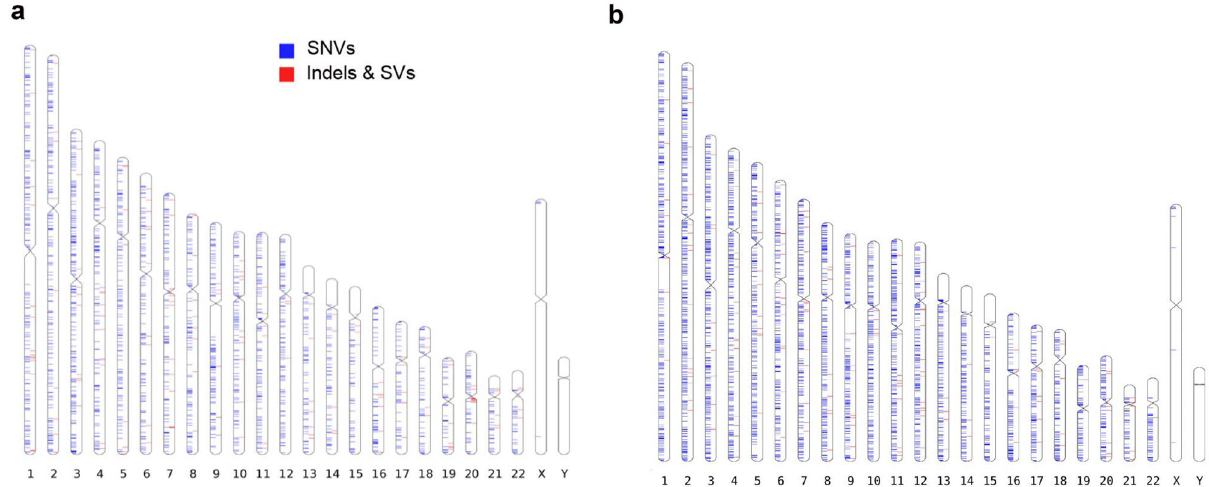
Figure 3. Chromosomal distribution of de novo mutations found in this study. ( A ) control families ( B ) NTV families. Plots drawn by Idiographica.